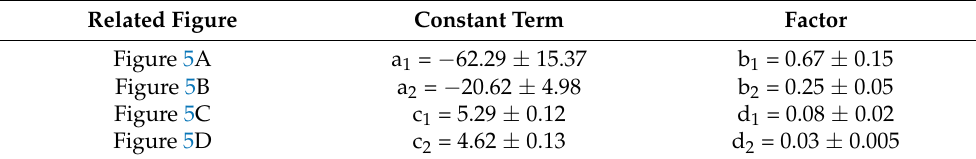
Table 4. Fit parameters to describe the relation between porosity or density and absorption